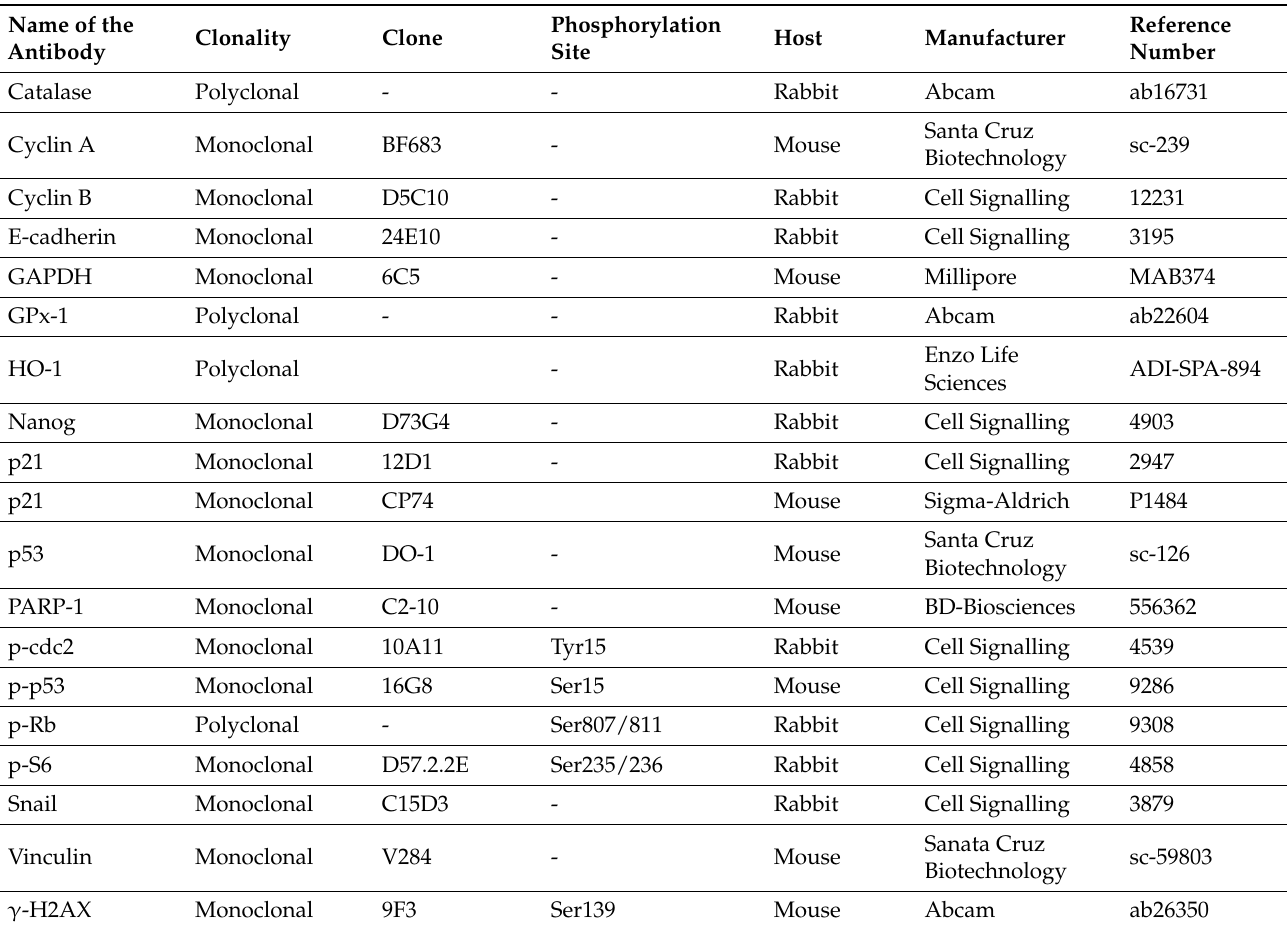
Table 1. List of the